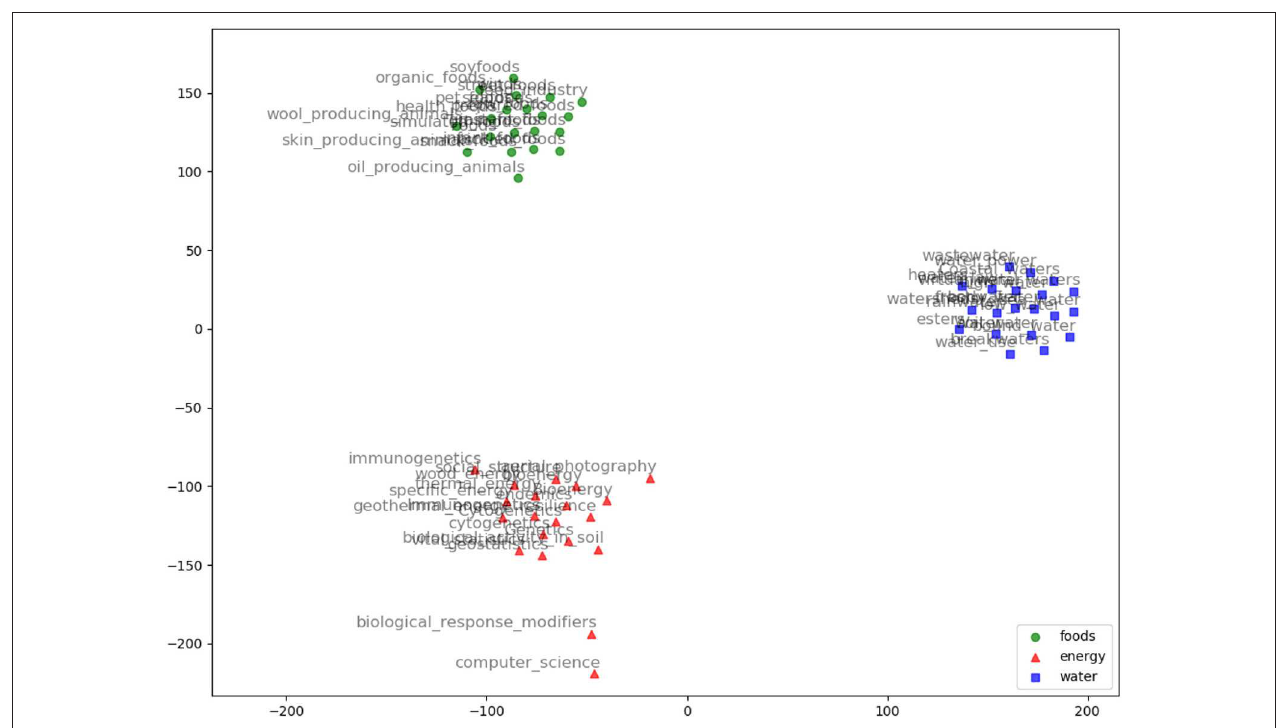
FIGURE 8 | FastText embeddings visualization using TSNE for the words: Food, Energy, and Water with their top 20 nearest neighbors based on fastText model.